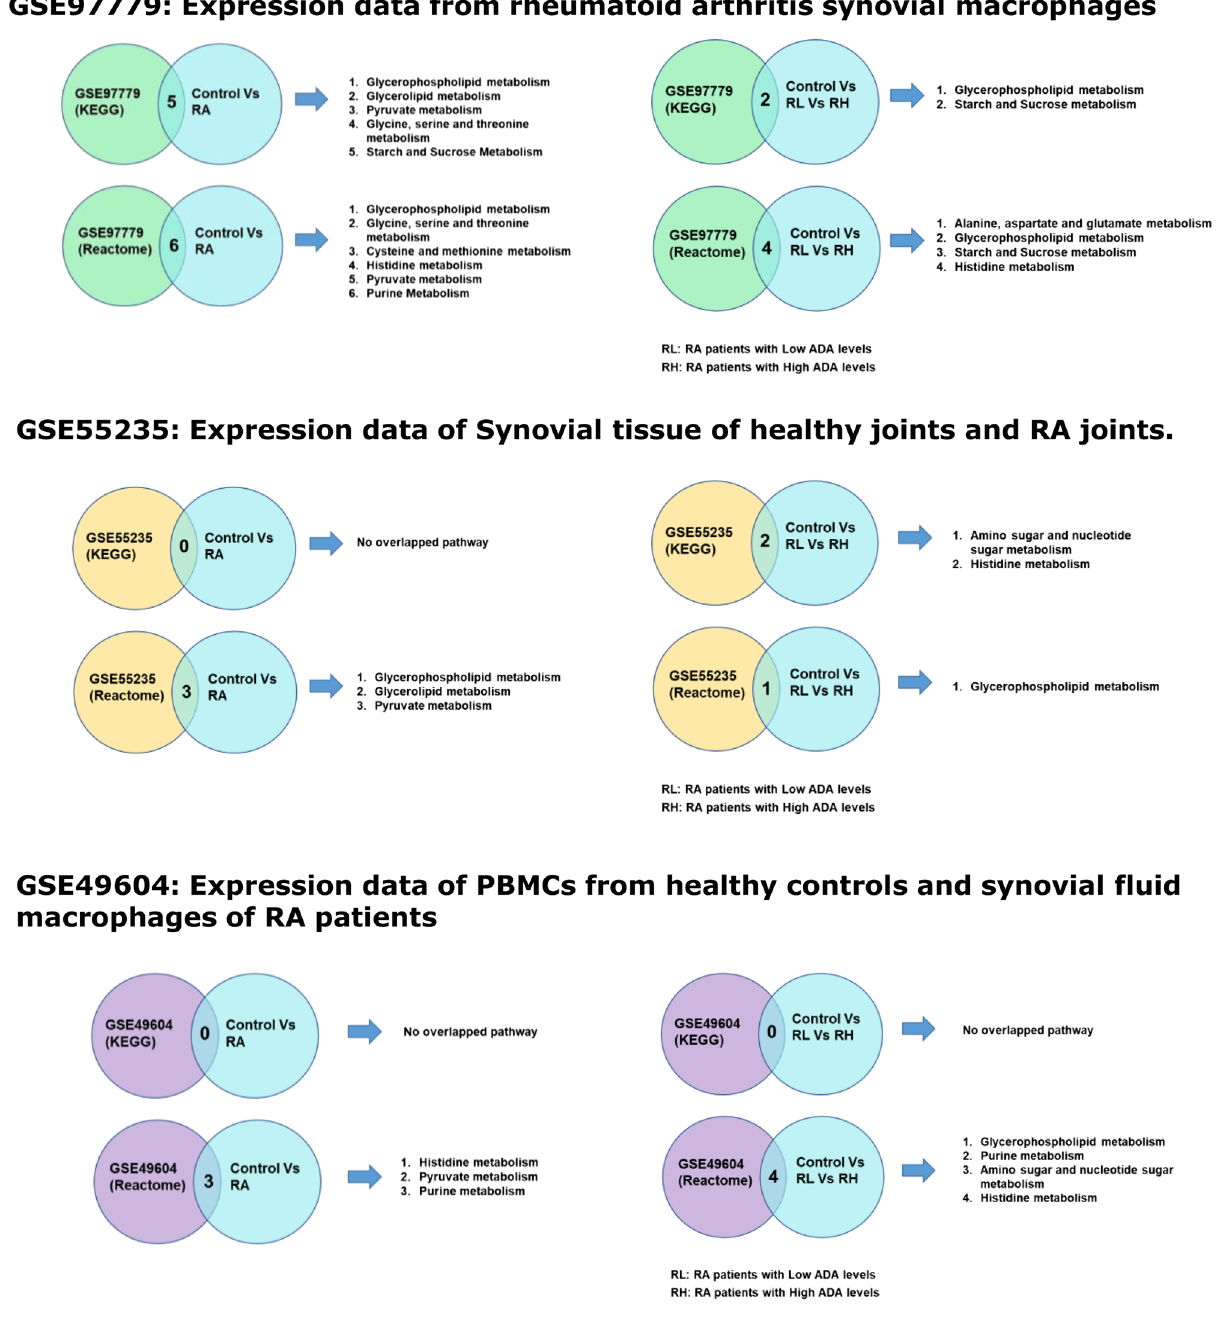
Figure 4. Correlation of Pathway analysis by ClueGO of GEO datasets—GSE97779, GSE55235 and GSE49604 with significant pathways from metabolomics data showed common pathways that has implications in pathophysiology of